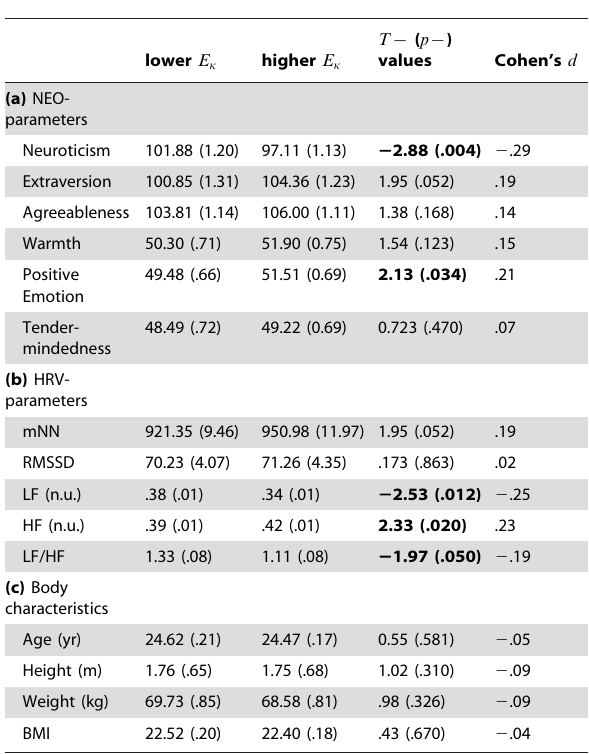
T { and p { values indicate results of independent samples t { tests, significant test results are indicated by bold font. The outermost right column provides effect sizes as indicated by Cohen’s d (Hedges’ bias correction, values . .2 indicate moderate effect sizes). Abbrevations: BMI: body mass index (body weight/body height 2 ); HF (n.u.): high frequency power (0.15–0.4 Hz) of the HRV in normalized units; HRV: heart rate variability; LF (n.u.): low frequency power (0.04–0.15 Hz) of the HRV in normalized units; RMSSD: root mean square of the SD of successive heart beat intervals.